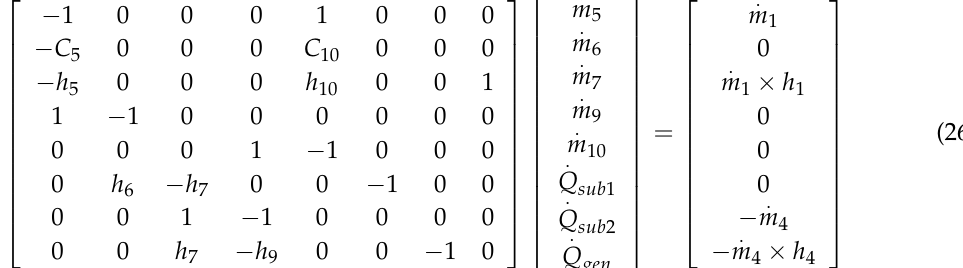
Figure 3. Contour plot of the COP (coefficient of performance) of the LiBr/water absorption refrigeration system equipped with an adiabatic absorber ((cid:1846) (cid:3030)(cid:3042)(cid:3041) = 35 ℃, (cid:1846) (cid:3032)(cid:3049)(cid:3028) = 10 ℃) .